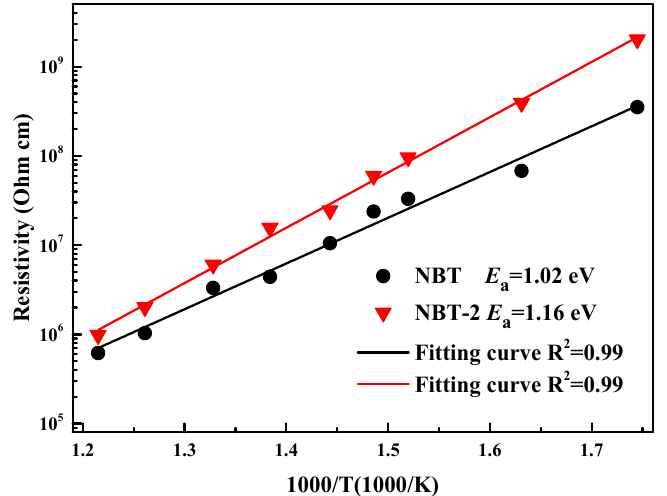
Figure 8. Temperature dependence of DC resistivity of the NBT and NBT-2 ceramics.